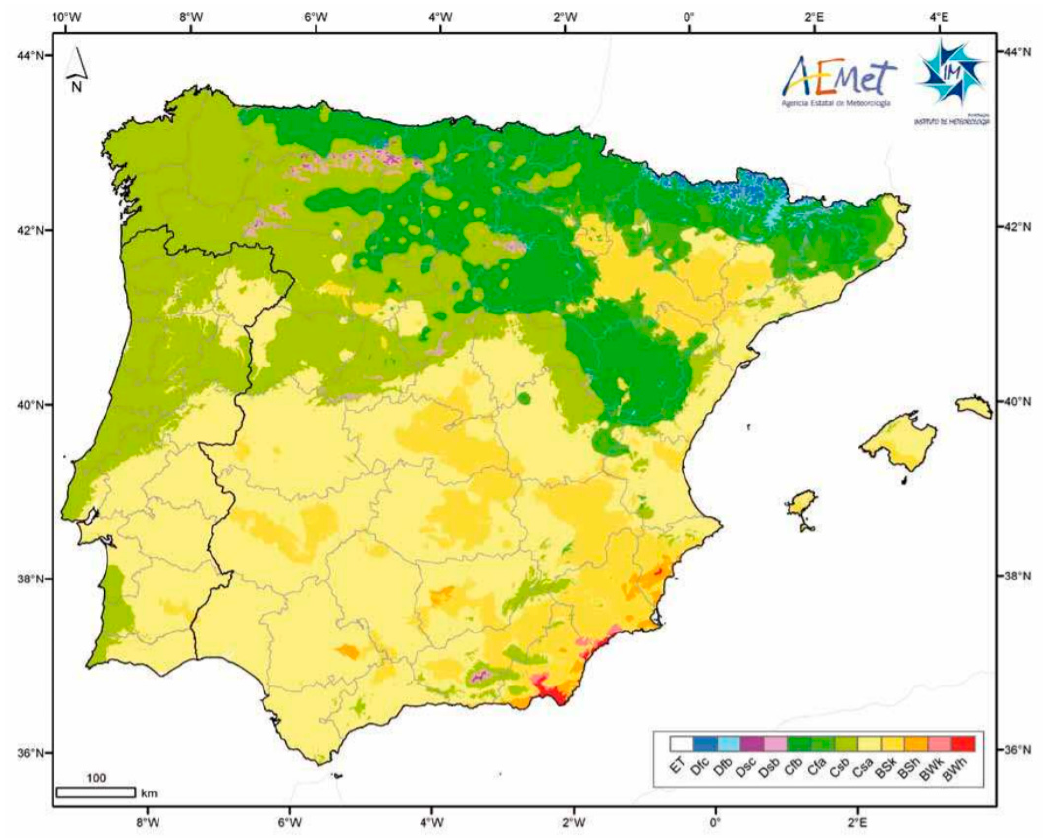
Figure 1. Köppen-Geiger Classification of the Iberian Peninsula and Balearic Islands [35].